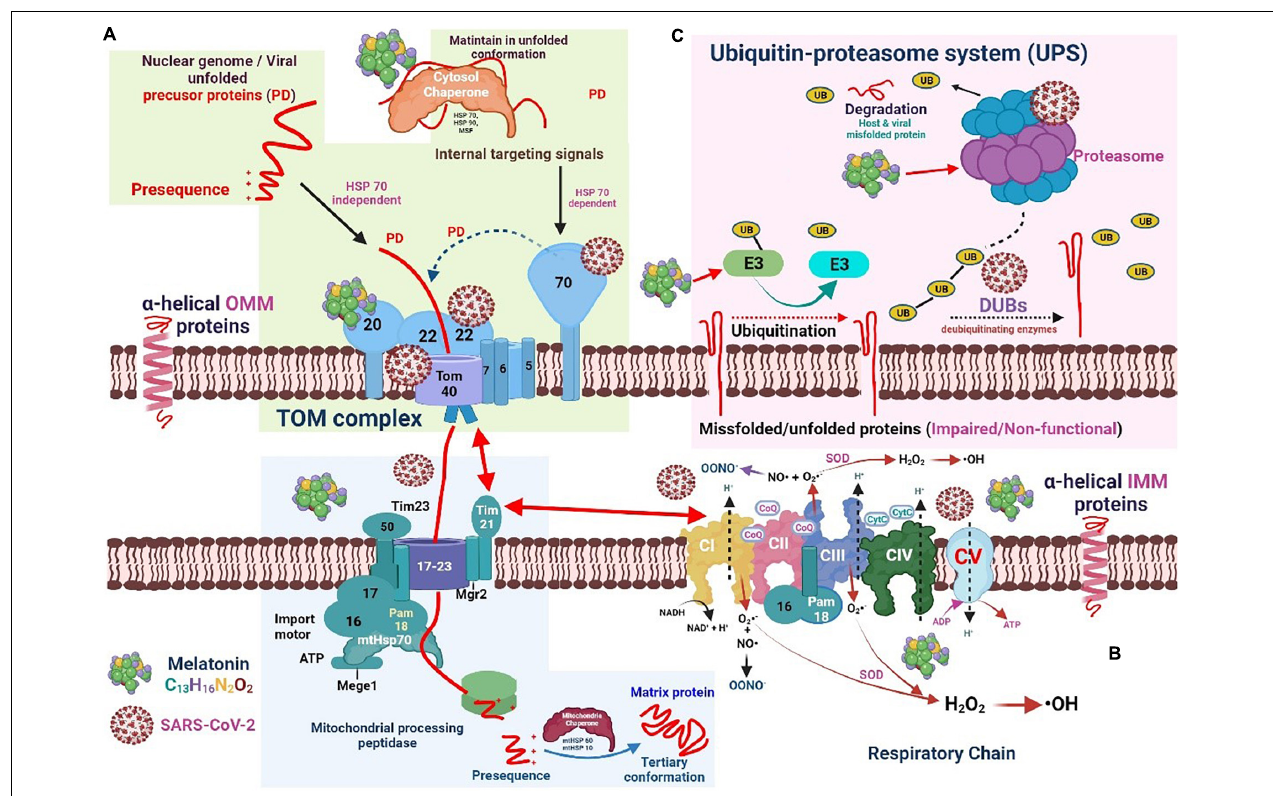
FIGURE 3 | The interaction of severe acute respiratory syndrome coronavirus 2 and melatonin with the chaperone-protease system and the respiratory electron transport chain machinery. (A) Viral unfolded precursor proteins translocate across mitochondrial membranes into the intermembrane space or mitochondrial matrix. Melatonin may regulate HSPs and proteasome activity which can improve mitochondrial function and restrict viral replication. (B) The mitochondrial electron transport complex (CI-CV) involved in oxidative phosphorylation, generating ATP. Free radicals are generated when electrons leak and reduce adjacent oxygen molecules to superoxide anion radicals (O 2 •− ). The pyrrole ring in melatonin may be suitable for capturing O 2 •− and • OH free radicals. (C) In the mitochondrial outer membrane, the ubiquitin-proteasome system (UPS) drives the quality control of proteins. Melatonin may decrease the level of downregulated protein 4-1 (E3